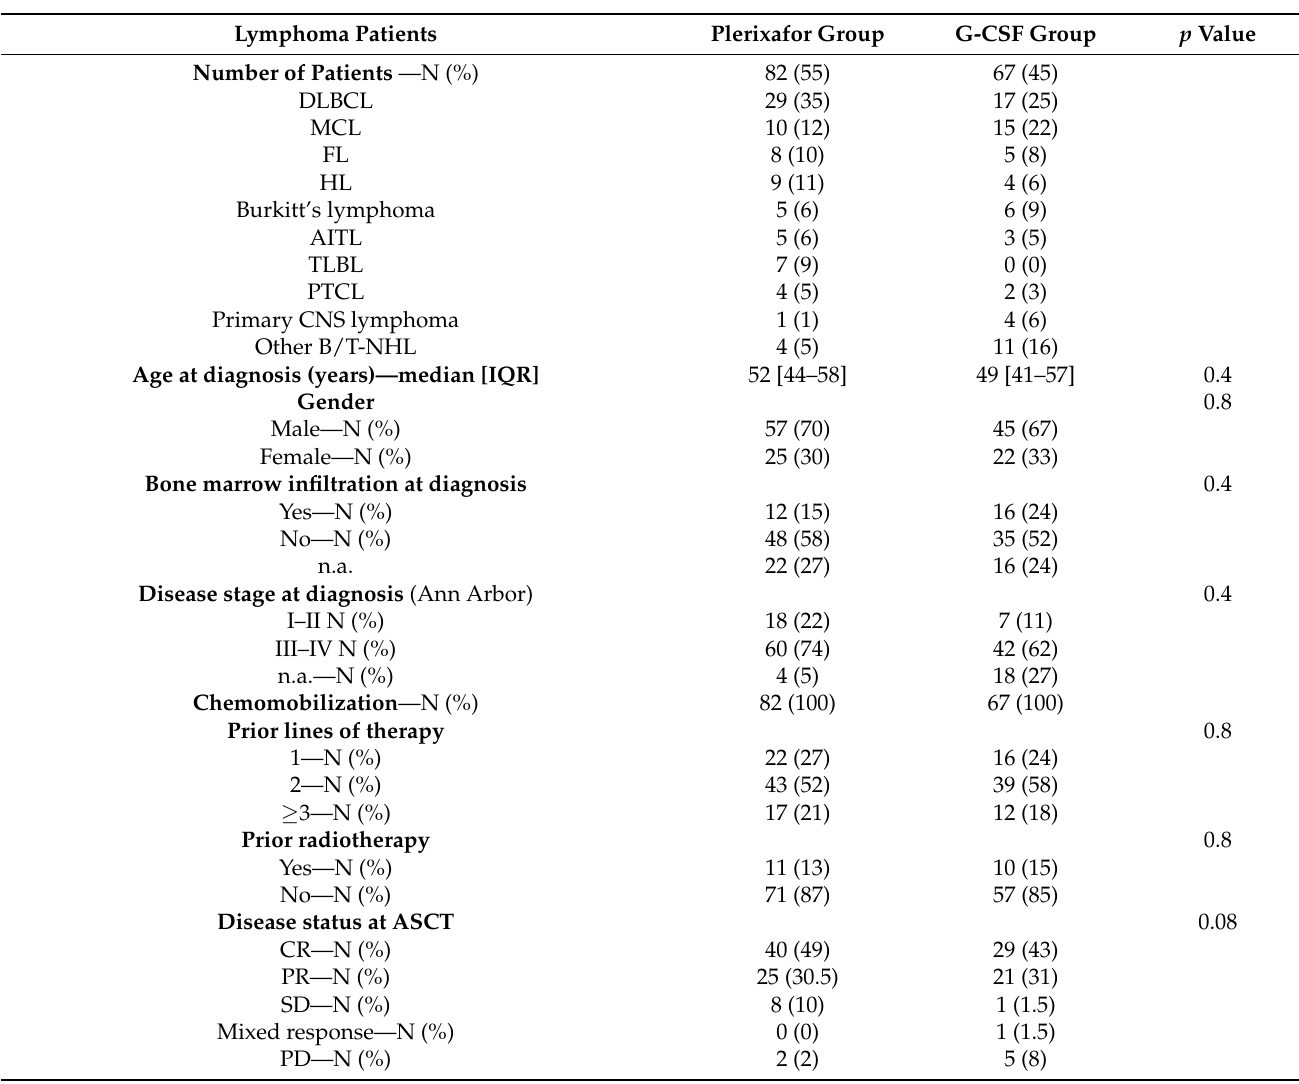
Table 2. Lymphoma patients and disease